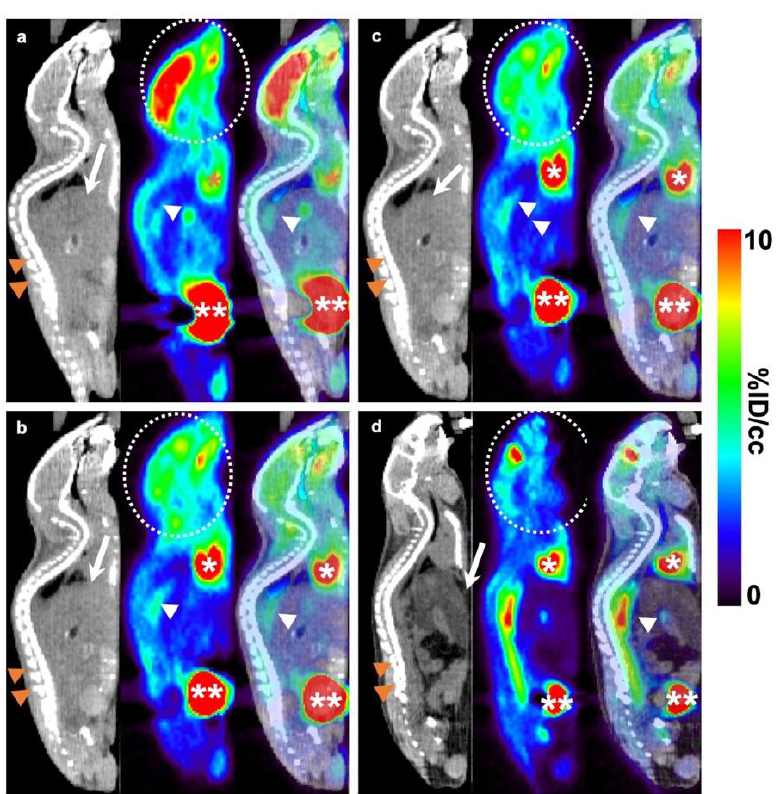
Figure 6. 18 F-FDG PET / CT evaluation. Sagittal views of MLT-treated mouse ( c , d ) and comparable views of a control mouse ( a , b ). Each panel shows, from left to right, CT only, PET only, and fused PET / CT images. Liver is recognized as a large solid structure in CT image and vertebral column as a hyperdense (white) posterior structure. In PET and fused PET / CT images, the sites with the most intense activity are the heart and the urinary bladder due to the normal excretion of 18 F-FDG by the kidneys (not shown in this section). The brain may demonstrate variable levels of 18 F-FDG uptake. The structure lying anterior to the vertebral column represents the abdominal aorta. Mild 18 F-FDG uptake is seen in its proximal part at the baseline PET / CT images taken from the control ( a ) and MLT-treated ( c ) mice. After 14 weeks of the atherogenic diet, a second PET / CT scan showed nearly unchanged FDG activity in the control mice ( b ) while, the MLT-treated group presented a significantly higher 18 F-FDG uptake in the same region of the aorta ( d ) compared to the baseline (respectively ( a ) for the control group and c for the MLT-treated mice). %ID / cc %injected dose per mL of tissue; white arrow indicates the liver; two orange arrowheads indicate the vertebral column; white asterisk indicates the heart; two white asterisks indicate the urinary bladder; white dashed circle indicates the brain; white arrowhead indicates the abdominal